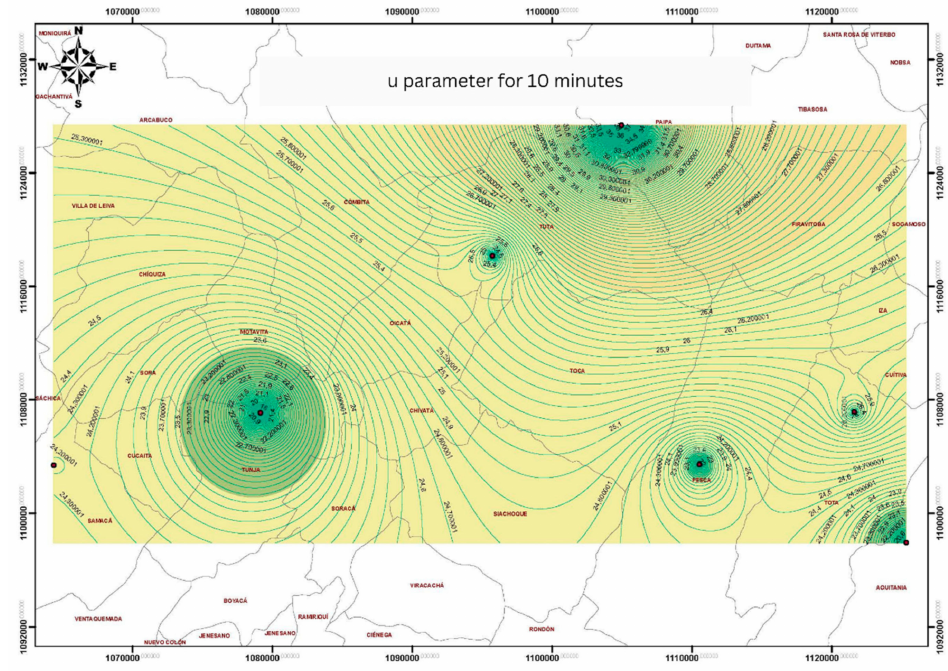
Figure 4. A regionalized map developed from the u parameter for 10